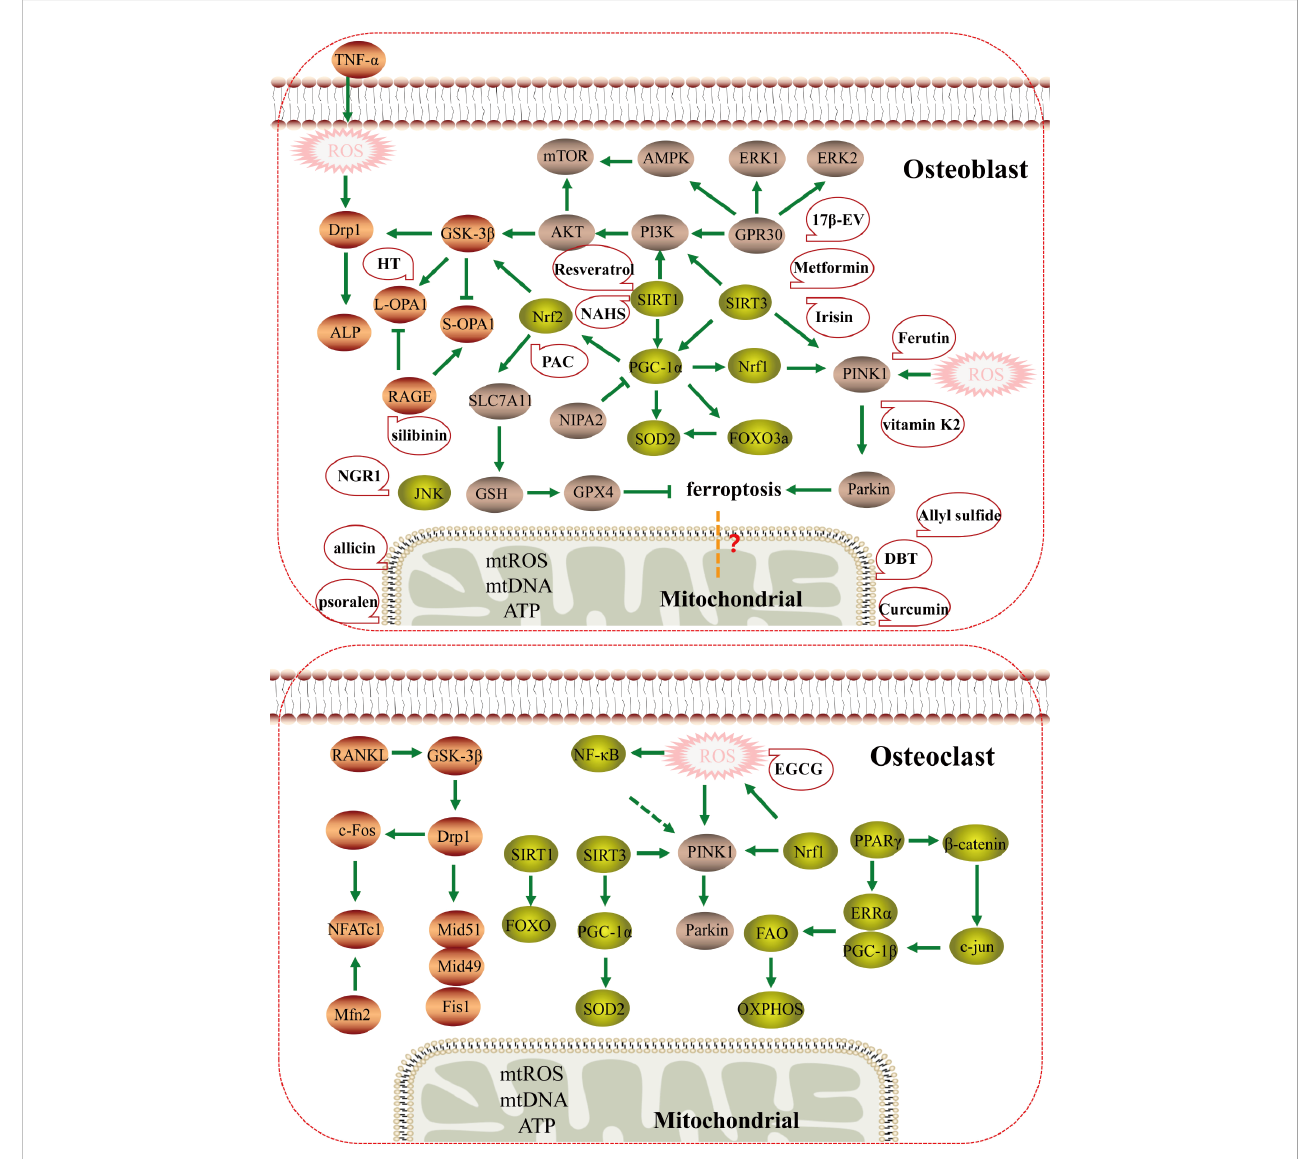
FIGURE 4 The mechanism and potential targeted therapy of mitochondria in osteoporosis. Mechanisms of mitochondrial dysfunction regulating osteoblasts and osteoclasts in osteoporosis; Mitochondrial dysfunction may have potential relationship with ferroptosis, and traditional Chinese medicine and natural medicine targeting mitochondria may have therapeutic